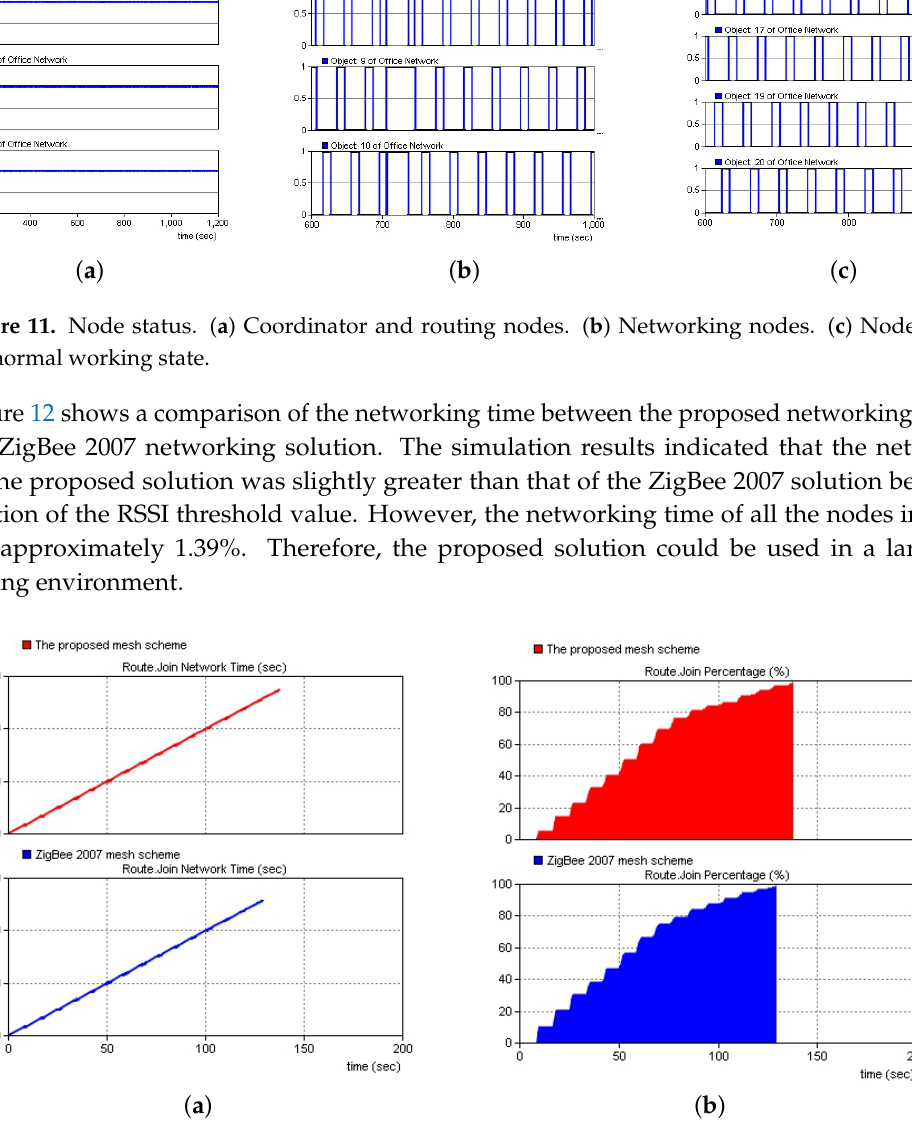
Figure 12. Comparisons of the networking time and proportions of networking nodes for the proposed solution and the ZigBee 2007 solution. ( a ) Networking time. ( b ) Proportion of networking